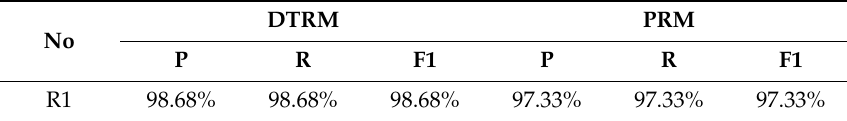
Table 3. Comparison results of Delaunay triangulation (DTRM) and (probability–relaxation–matching) PRM in Area 1.